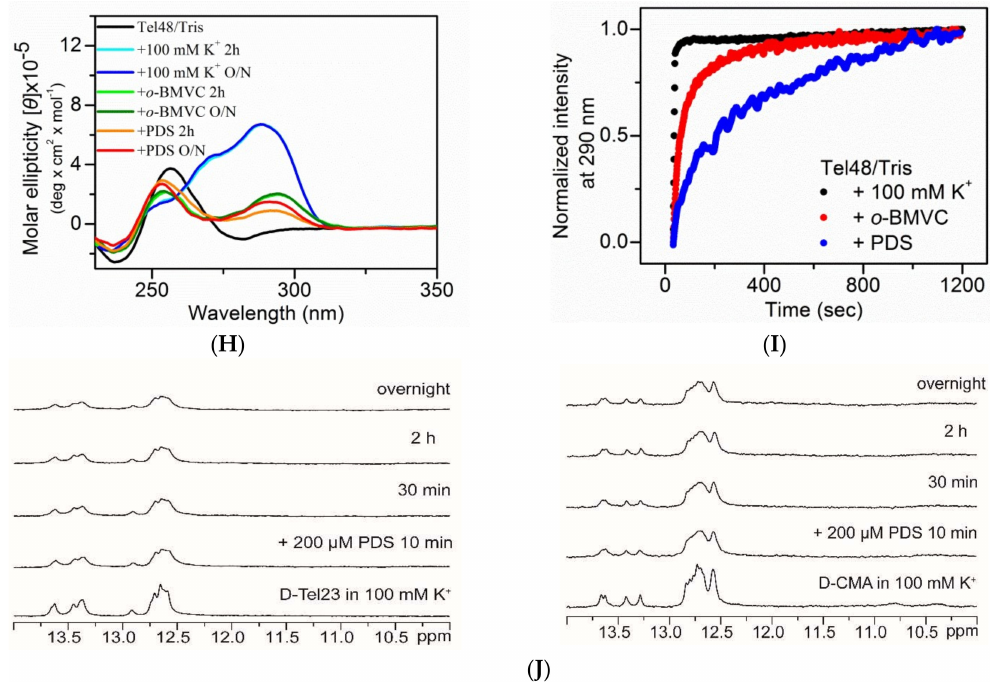
Figure 2. Study of G4 ligands in vitro. ( A ) The CD spectra and ( B ) CD melting curves of Tel48 in 100 mM K + solution without and with o -BMVC, BMVC4, BRACO-19, TMPyP4 and PDS. ( C ) Kinetic binding curves for the interaction of o -BMVC and TMPyP4 with Tel48 fit to a two-site binding model (red lines) using the built-in software of ForteBio. The experiments were conducted in 10 mM Tris buffer with 100 mM K + at 25 ◦ C. ( D ) The UV shadowing ( left ) and post-stained by o -BMVC ( right ) of 40 µ M Tel48 (lane 1) and its complexes with 80 µ M of o -BMVC (lane 2), BMVC4 (lane 3), BRACO-19 (lane 4), TMPyP4 (lane 5) and PDS (lane 6). ( E ) The fluorescence spectra of 2 µ M o -BMVC and